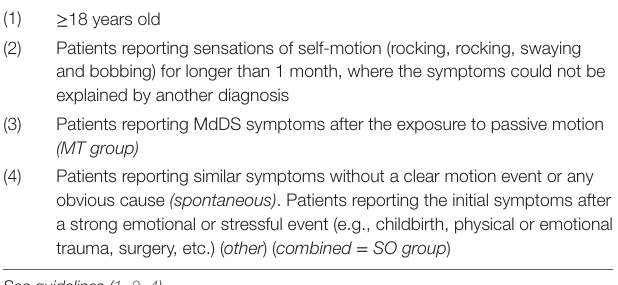
Table 1 | Inclusion criteria used for this